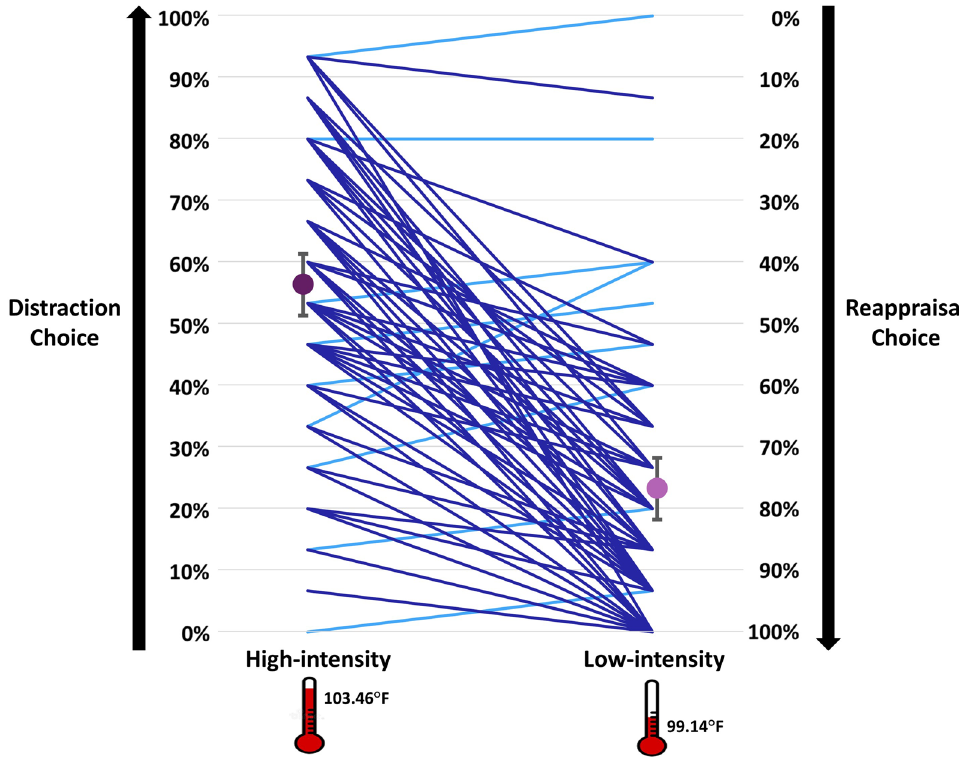
Figure 4. Average regulatory selection preferences for high (dark purple circle) versus low intensity (light purple circle) sentences. Bars represent 95% confidence intervals (CIs) for distraction choice in high intensity (around the dark purple circle) and for reappraisal choice in low intensity (around the light purple circle). For each emotional intensity level, the left y-axis shows distraction choice percentages and the right y-axis shows reappraisal choice percentages (summing up to 100%). The blue lines connect between average distraction choice in high intensity and average reappraisal choice in low intensity for each individual participant. Note that dark blue lines (86.67% of participants) represent the predicted pattern of distraction over reappraisal preference in high intensity, but reappraisal over distraction preference in low intensity, whereas light blue lines represent the opposite pattern.